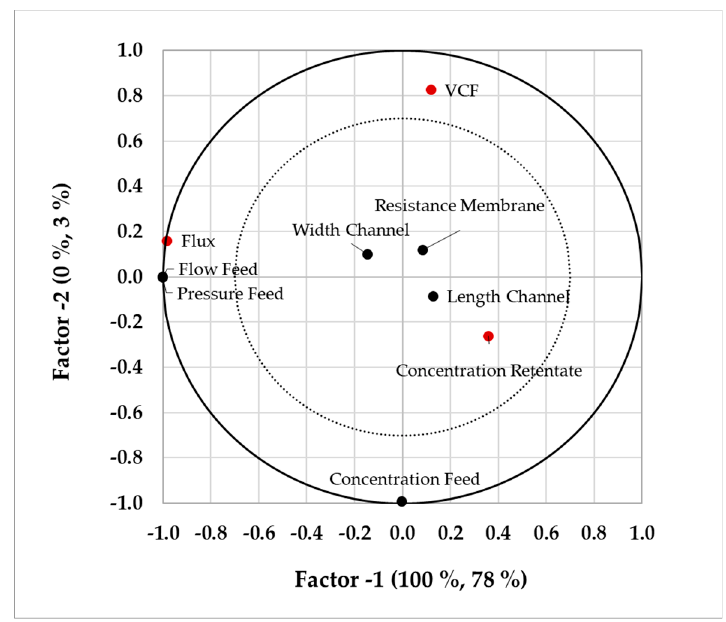
Figure 10. Correlation loadings plot visualizing the dependencies of the variables based on Monte Carlo simulations.